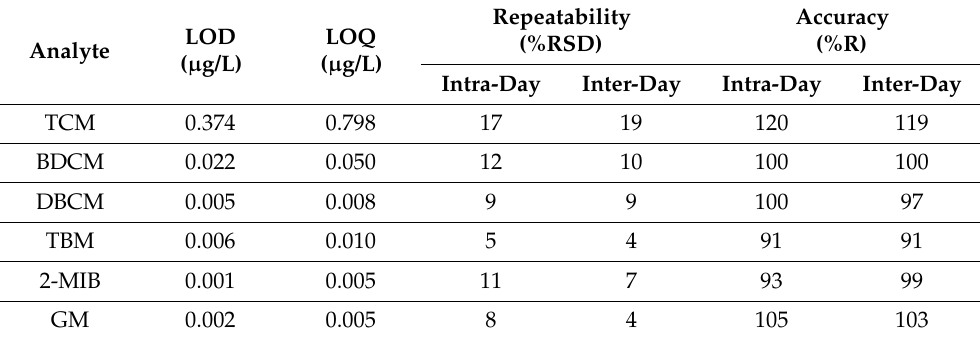
Table 5. Values of LOD and LOQ for intra-day and inter-day repeatability and accuracy of the HS-SPME-GC/MS method of THMs and